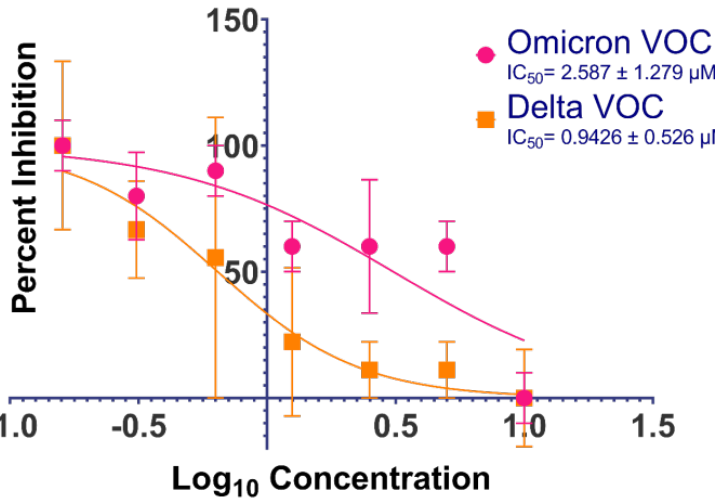
Figure 5. Various doses of top performing tosyl-L-trypophan cyclobutanone 4 against Omicron SARS-CoV-2 and a dose-response with greater efficacy against the Delta variant. Table 2. IC 50 values of select cyclobutanone derivatives against wild-type as well as Delta and Omicron variants for tosyl-L-Trp-cyclobutanone 4